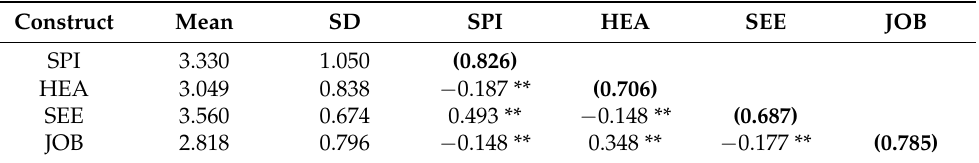
Table 3. Discriminant validity test.